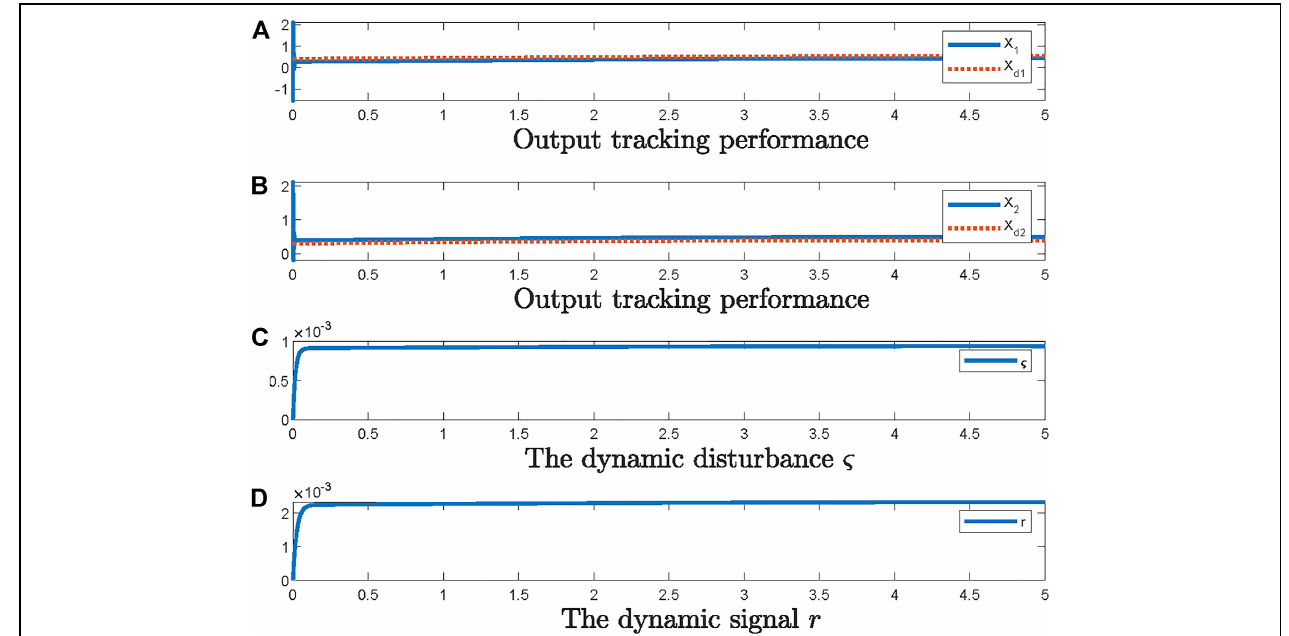
Frontiers in Energy Research |